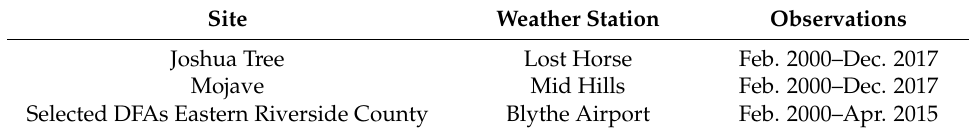
Table 2. Weather stations for each study site. Locations are indicated in Figure 1.